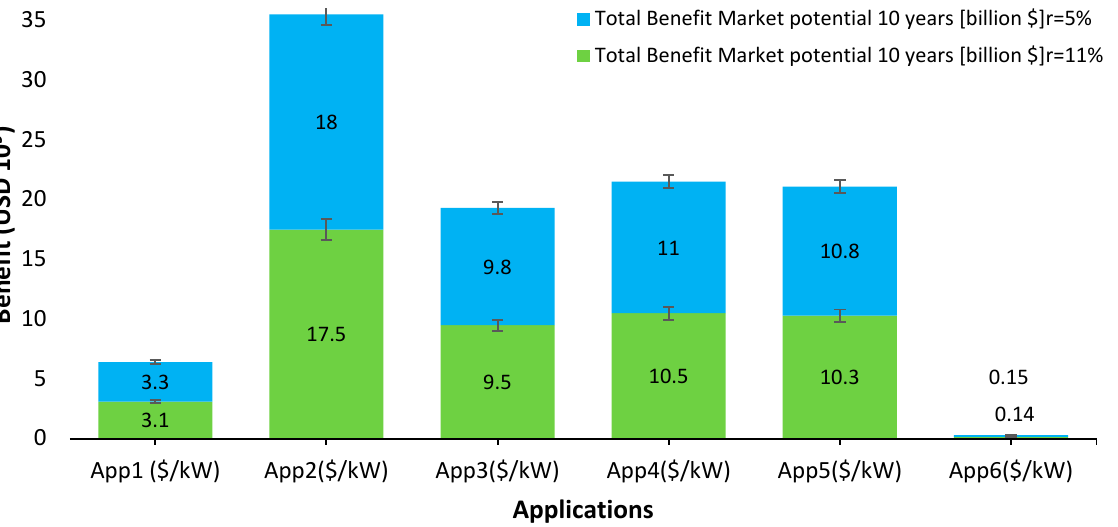
Figure 15. The total market potential benefit in 10 years (USD billion) as a function of the application list (App1–App6) and a discount rate of 5% up to11%.